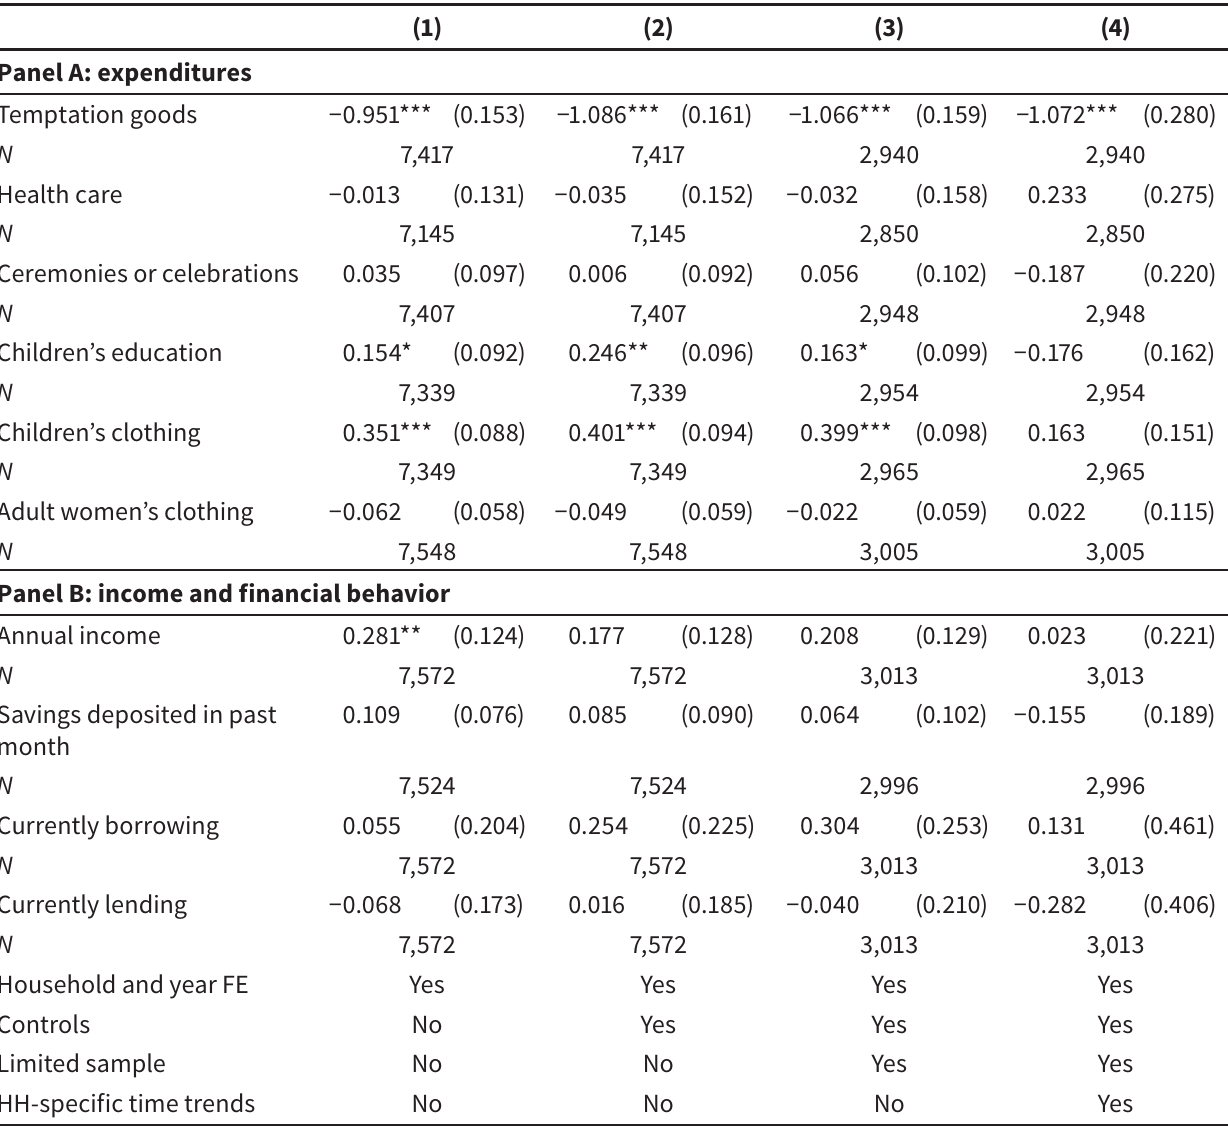
Changes in expenditures, income, and financial behavior as the husband’s migrant status changes